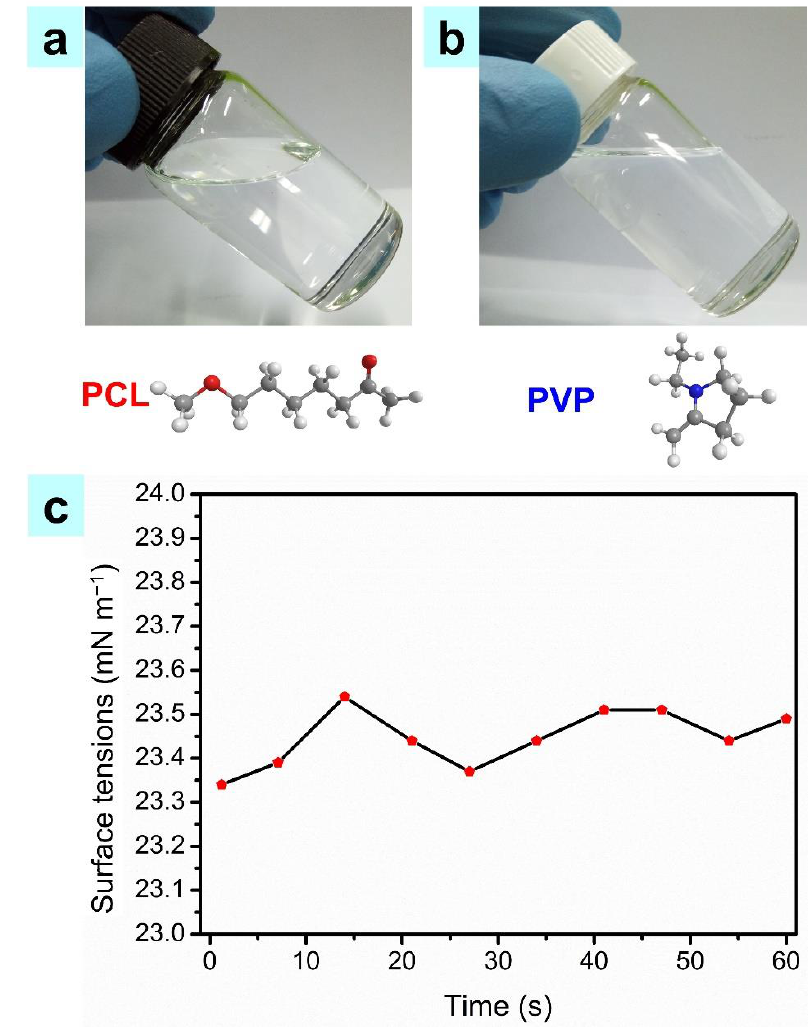
Figure 2. ( a ) The PCL ink; ( b ) The PVP ink; ( c ) The measured surface tensions of the composite ink.